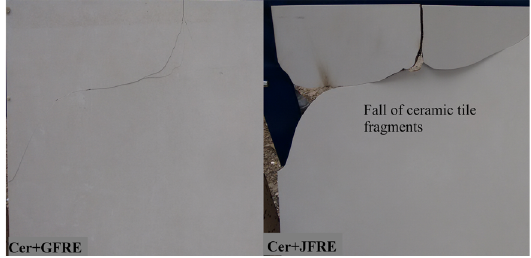
Figure 11. Fracture of the ceramic tile during the flame propagation